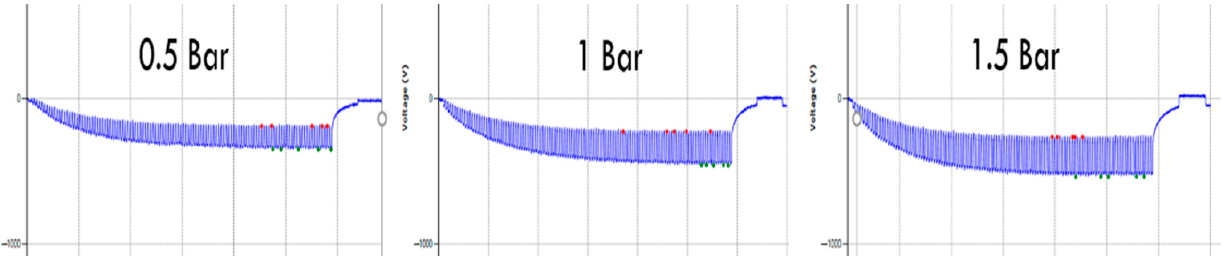
Figure 7. Effect of different pressure on the electrostatic waveform. Table 2. Effect of different pressure on the electrostatic charge generation.